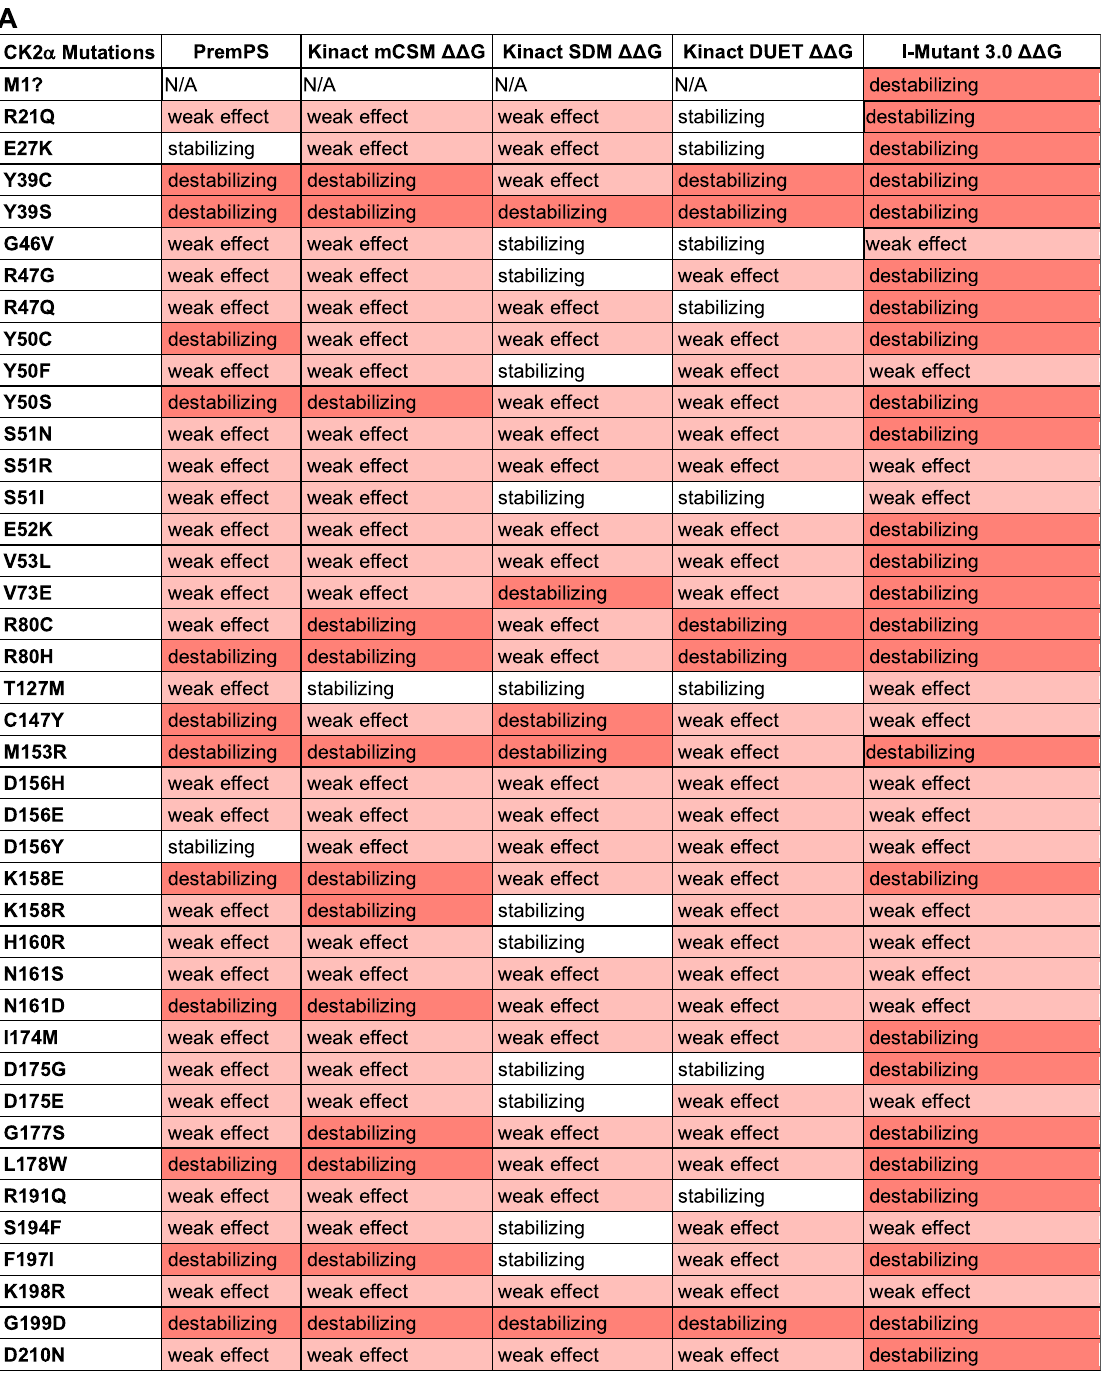
TABLE7AnalysisoftheCK2proteinmutationsusingstabilitypredictiontools.PredictionsforeachmutantinCK2 α (A)andCK2 β (B)accordingtoeach program. Highlight colors in the cells re fl ect the effect from stabilizing (white) to high destabilizing (red). The numbers obtained in the